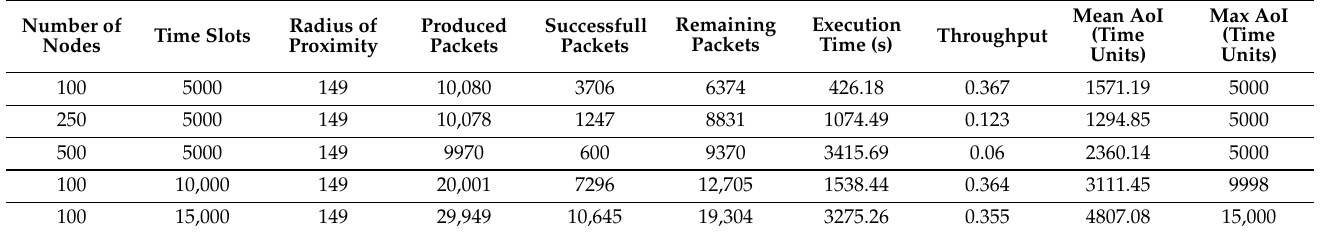
Table 13. Larger scale simulation for FRESH-near-v2.